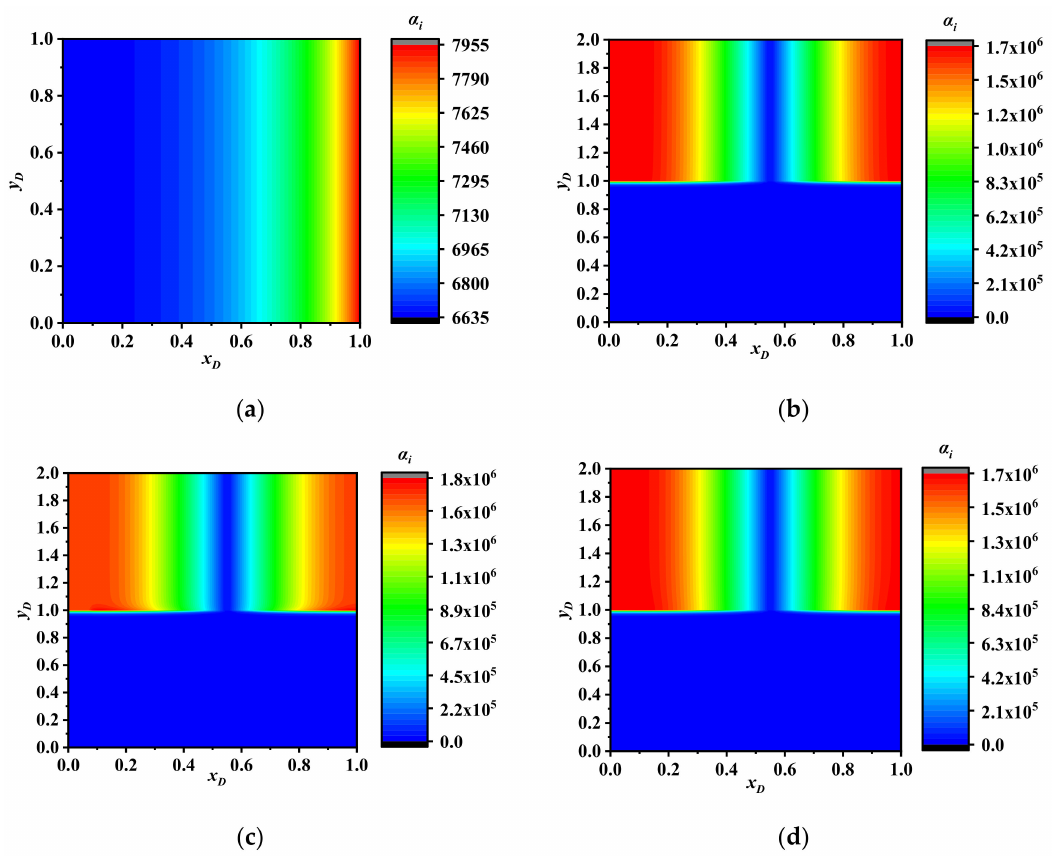
Figure 10. Spatial distribution of time scale 8 × 10 − 4 contribution. ( a ) Natural fracture. ( b ) Matrix. ( c ) Kerogen pore. ( d ) Kerogen